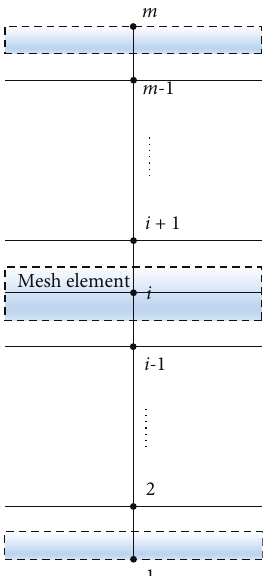
Figure 5: Schematic diagram of the mesh discretization of the physical